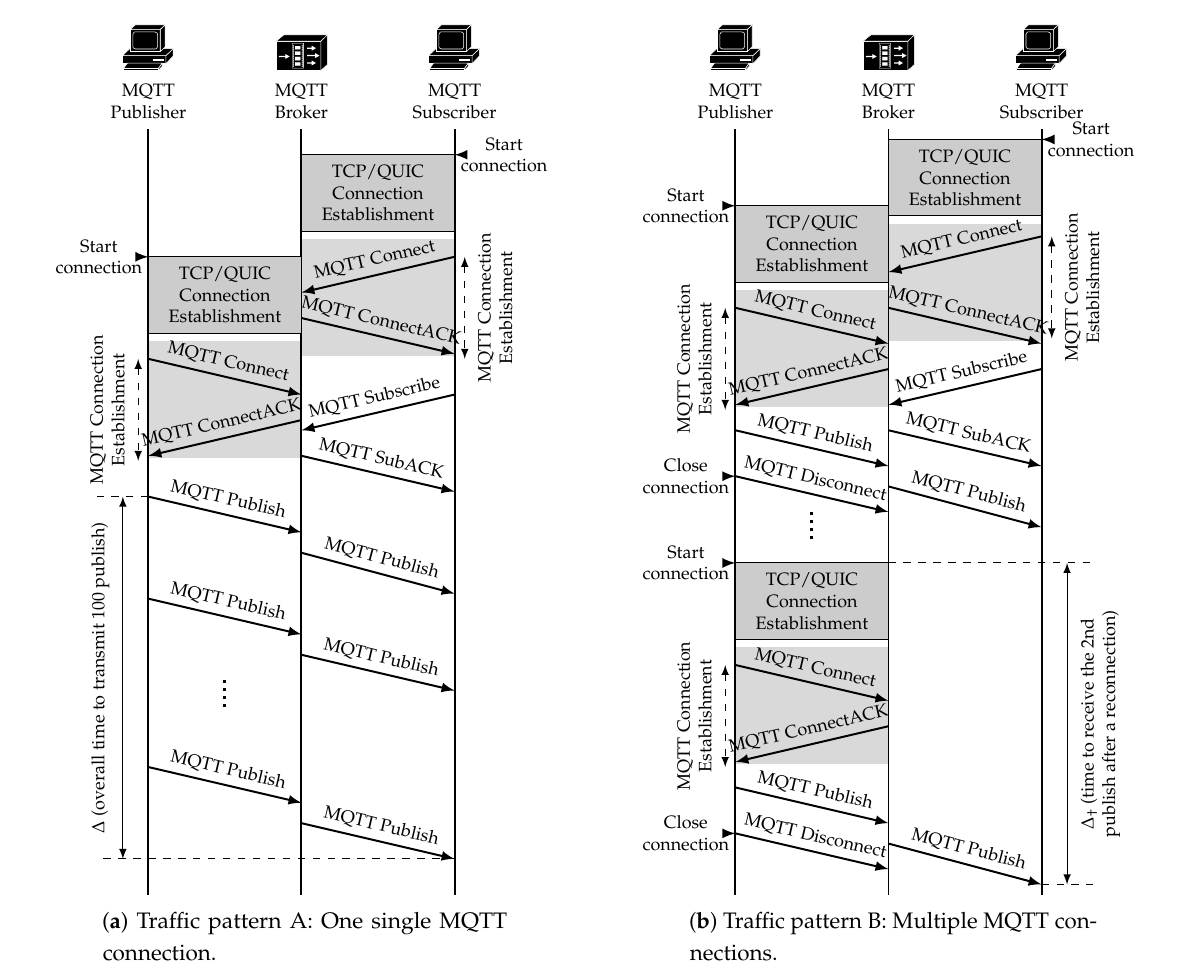
Figure 6. Traffic patterns used during the